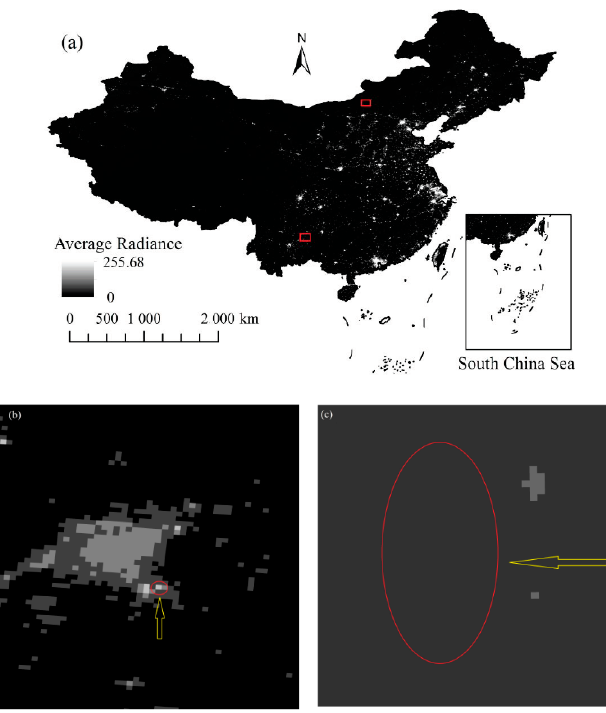
Figure 3. ( a ) The corrected NPP / VIIRS nighttime light image of china in January 2013; ( b ) the corrected image of sampling area No.1; ( c ) the corrected image of sampling area No.2.